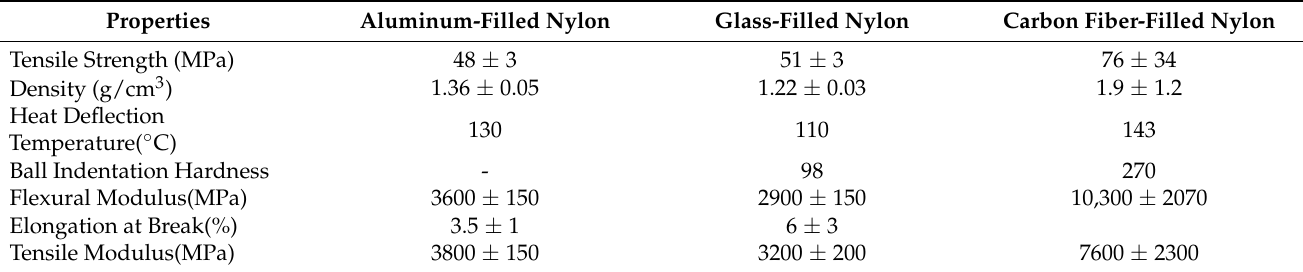
Table 5. Some important types of nylon composite